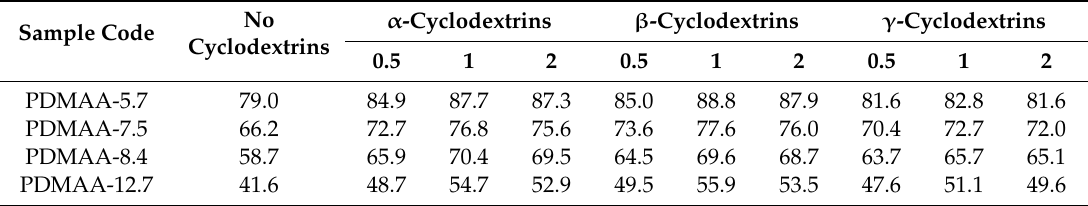
Table 2. T cp of copolymer in aqueous solution related types and quantity of